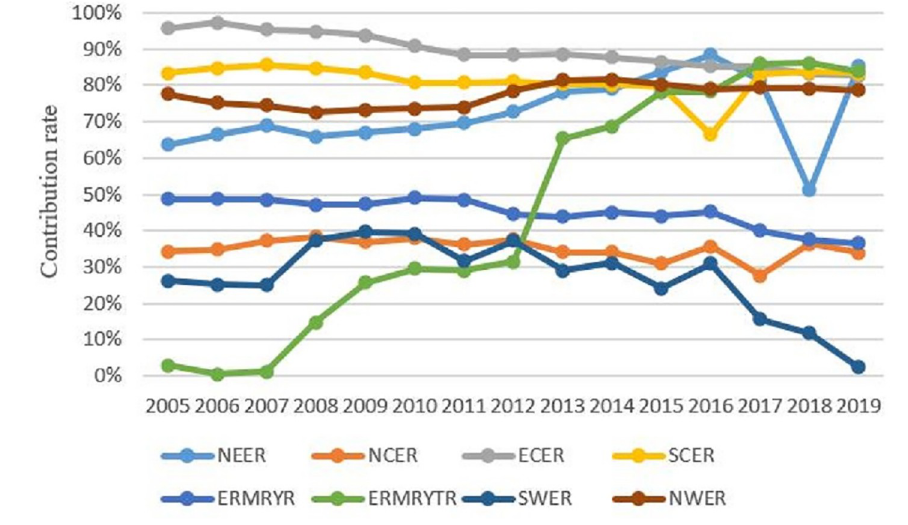
Fig 7. The contribution rate of inter-regional